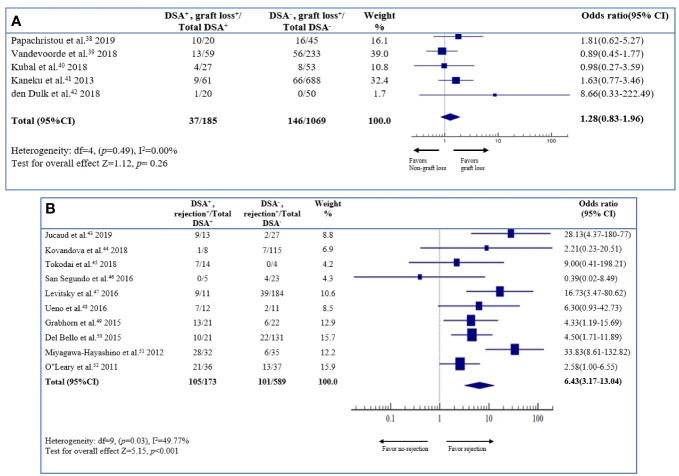
Association between de novo DSAs and (A) the risk of graft loss, (B) rejection. Forest plot of comparison of patients with de novo DSA vs. those without de novo DSA in each outcome.